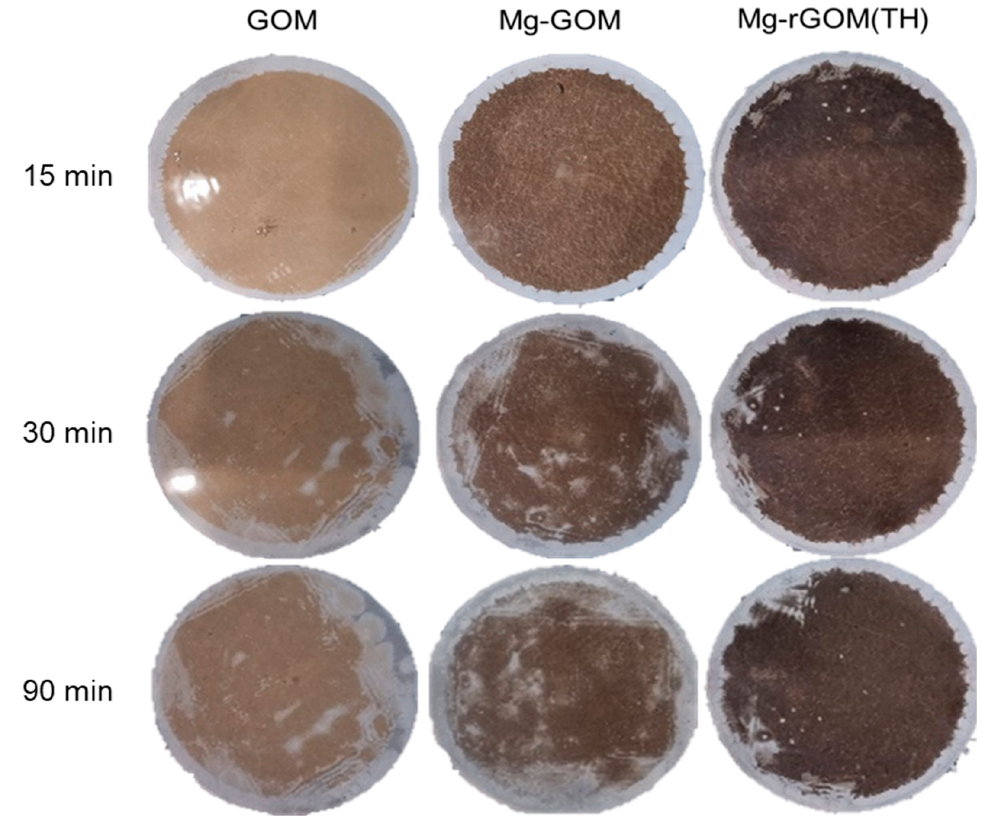
Figure 8. Structural durability of GOM, Mg-GOM, and Mg-rGOM(TH) membranes, observed at different sonication times in the water.